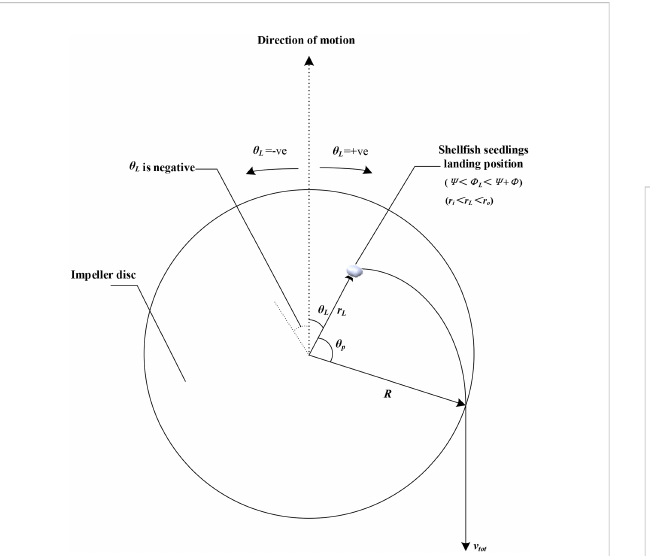
angle of the blanking port, r i is the inner diameter of the blanking port, r o is the outer diameter of the blanking port, R is the radius of the disc, and v tot is the exit velocity of the shell fi sh seedling at the edge of the disc. The particles of shell fi sh seedlings are placed in a speci fi c position ( R , q p ) disengage the bladed disc. Figure 6 illustrates the velocity analysis of a shell fi sh seedling moving on an impeller disk. Where a tot is the angle between the horizontal plane and the exit direction of the seedling; b tot is the angle